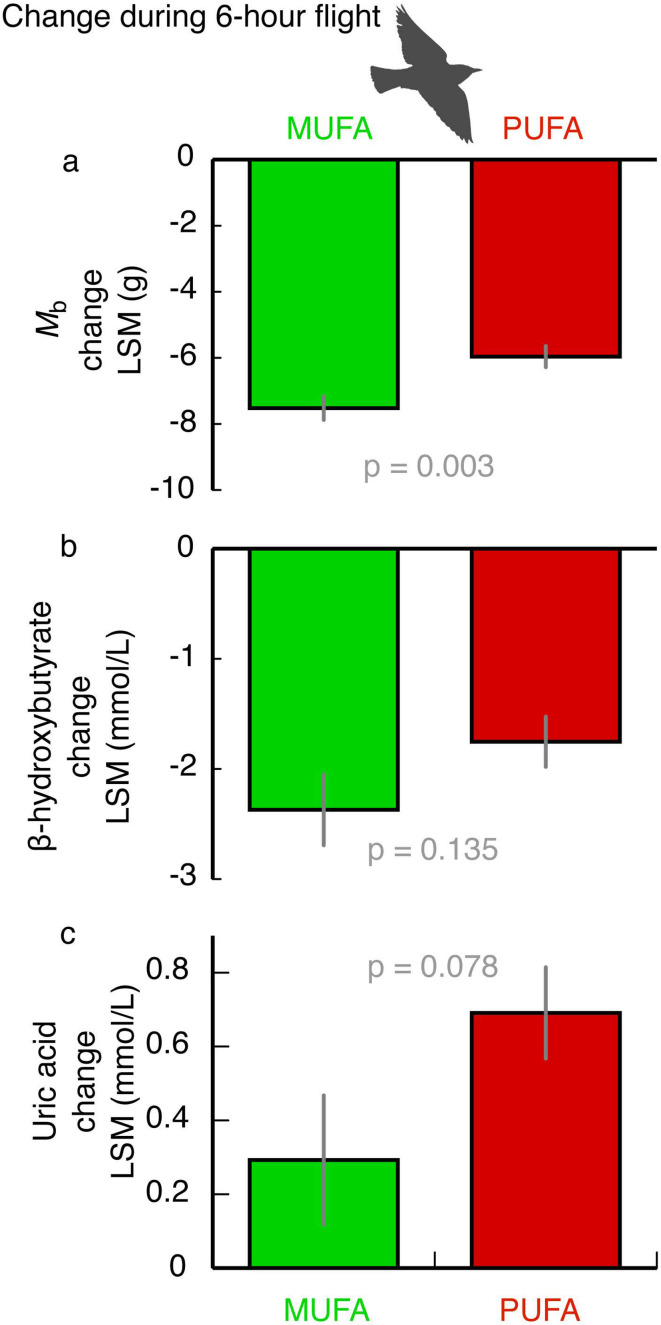
Change in (a) body mass, (b) Beta-hydroxbutyrate, and (c) uric acid in plasma of European starlings (n = 33) during their long-duration (6 hr) flights in Experiment I.Plasma samples were collected just before departure on the flight and immediately after completion of their long-duration flight. Body mass was included as a fixed covariate so we report the results as least square means (LSM).